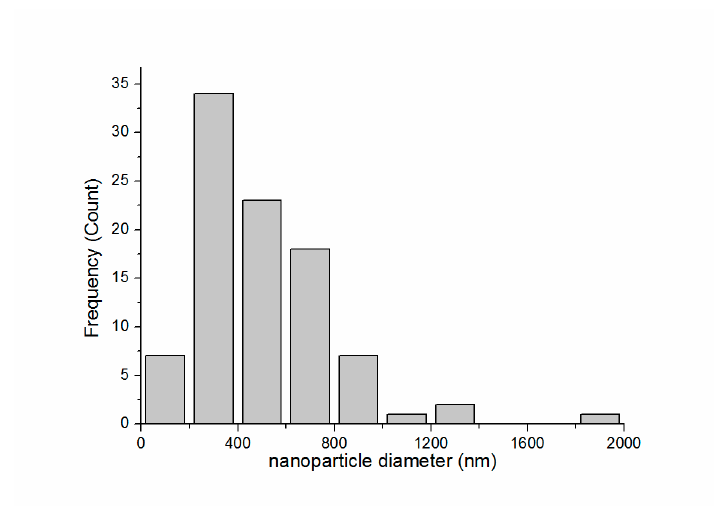
Figure 5. Aggregate size distribution of PVB ‐ ATOc ‐ 5.